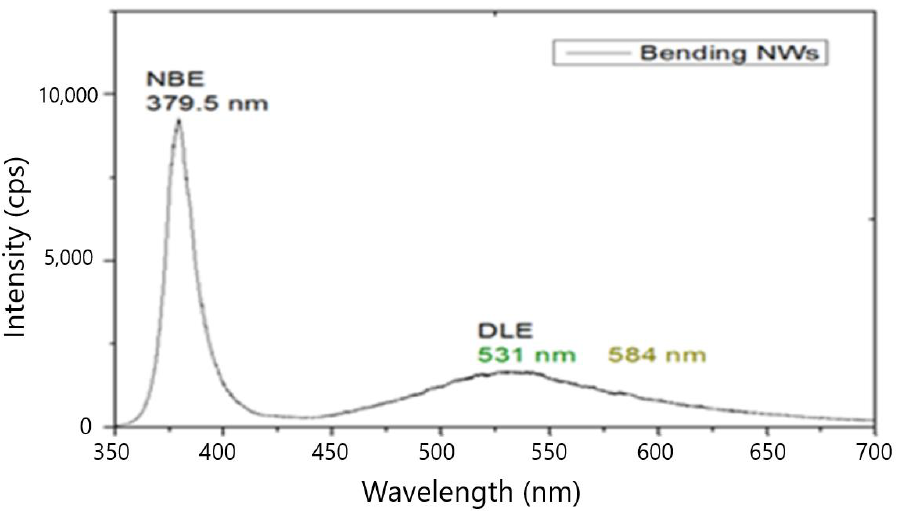
Figure 4. PL Spectrum of ZnO Nws grown on Glass-ITO + ZnO SL at 10 Torr, Tsub < 500 °C d target – substrate = 6.5 cm.